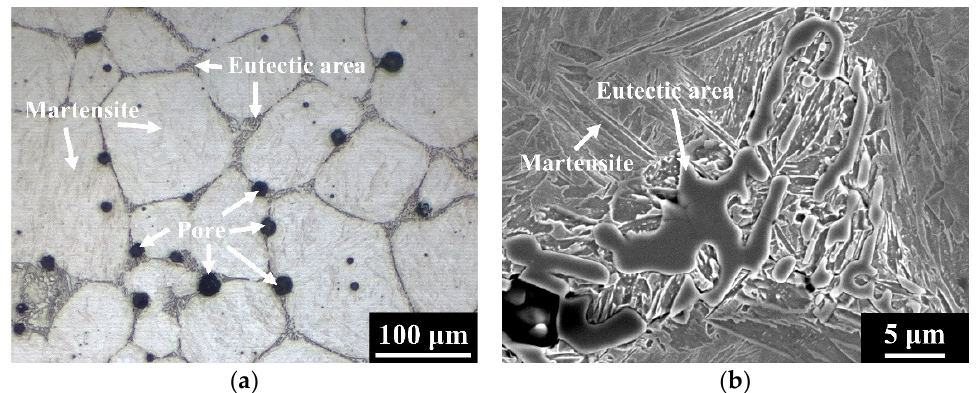
Figure 4. Microstructures of the ( a ) 410L and ( b ) 410L + 0.6B PM stainless steels. ( c ) High magnifi- cation of a eutectic area in 410L + 0.6B.